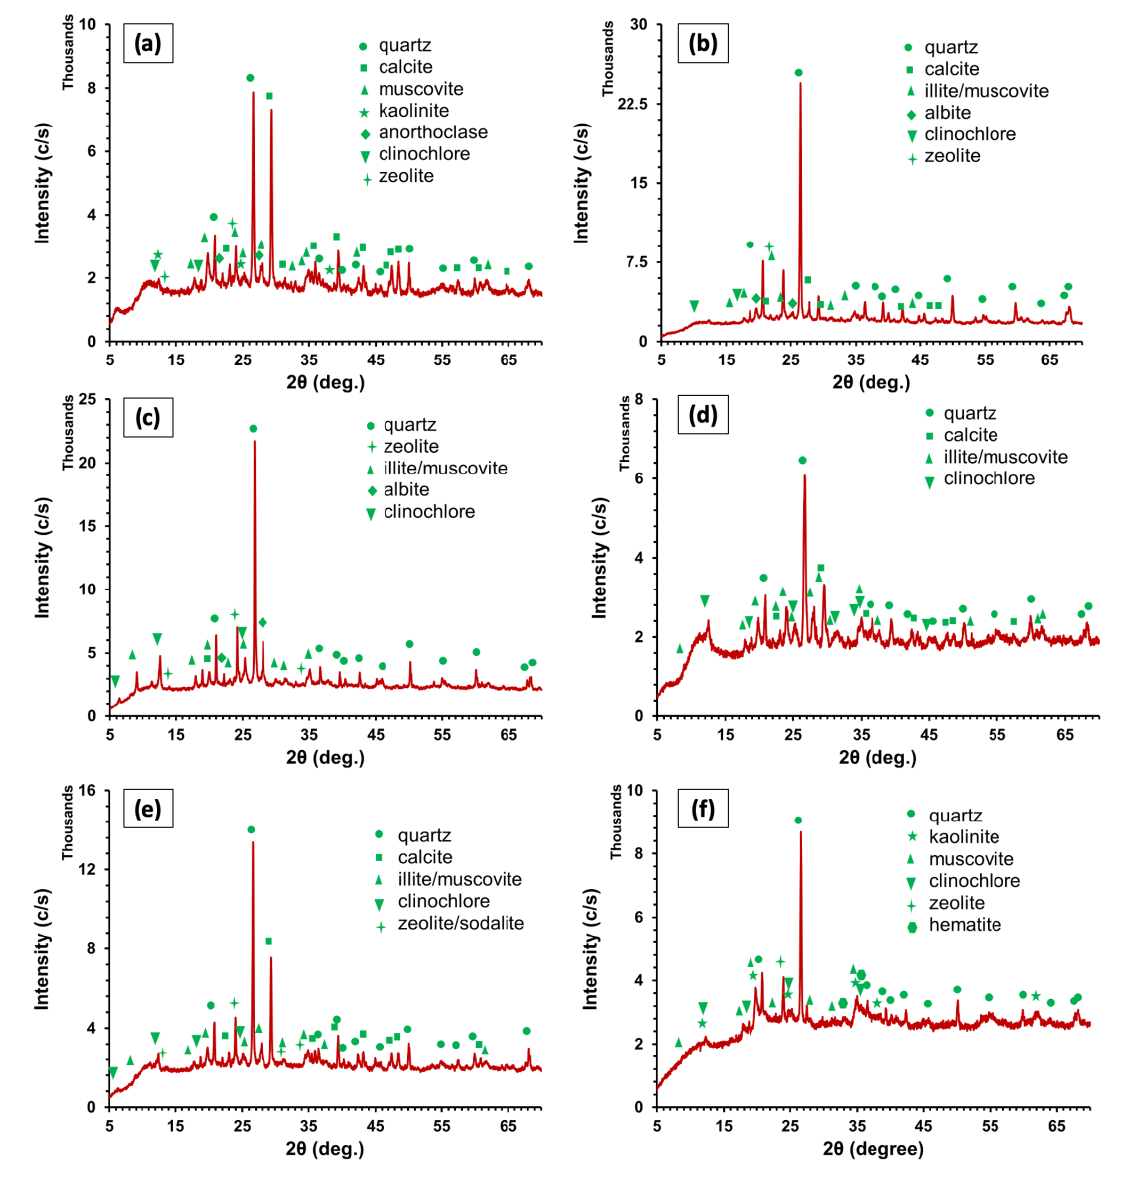
Figure 8. XRD patterns of ( a ): Clay I, ( b ): Clay II, ( c ): Clay III, ( d ): Clay IV, ( e ): Clay V, ( f ): Clay VI.